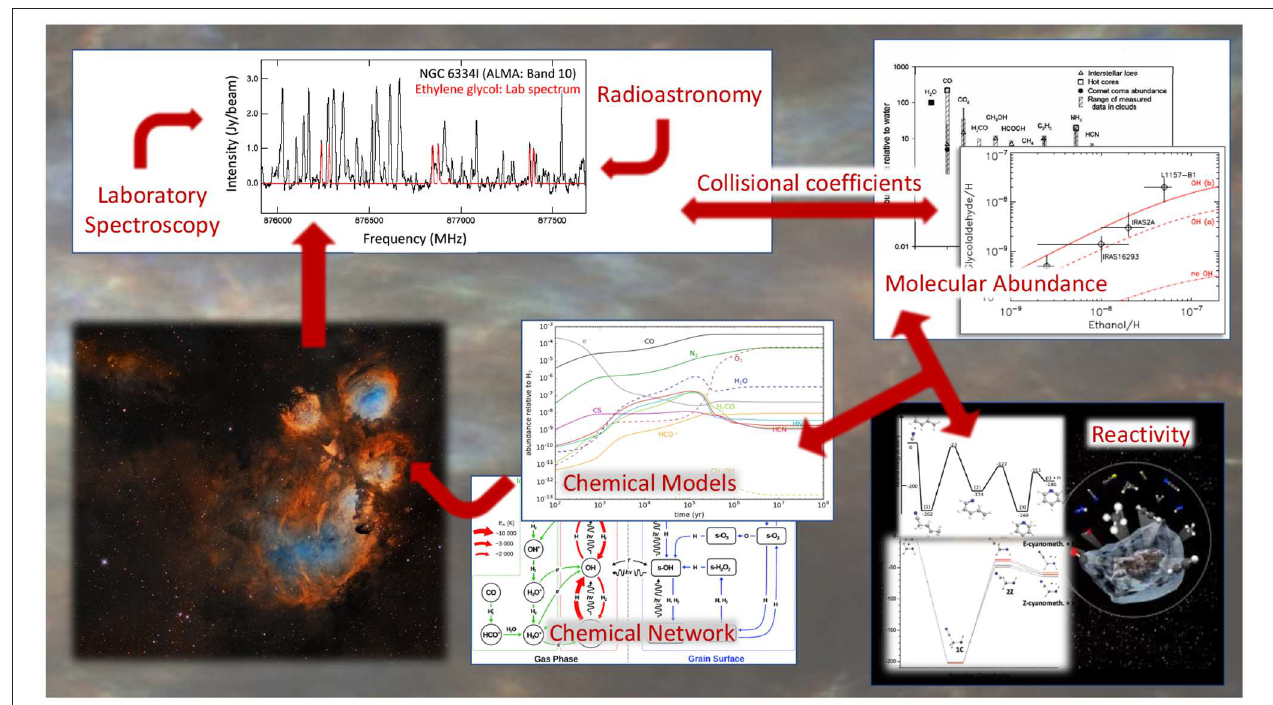
FIGURE 1 | Grand challenge 1: The stakeholders and their